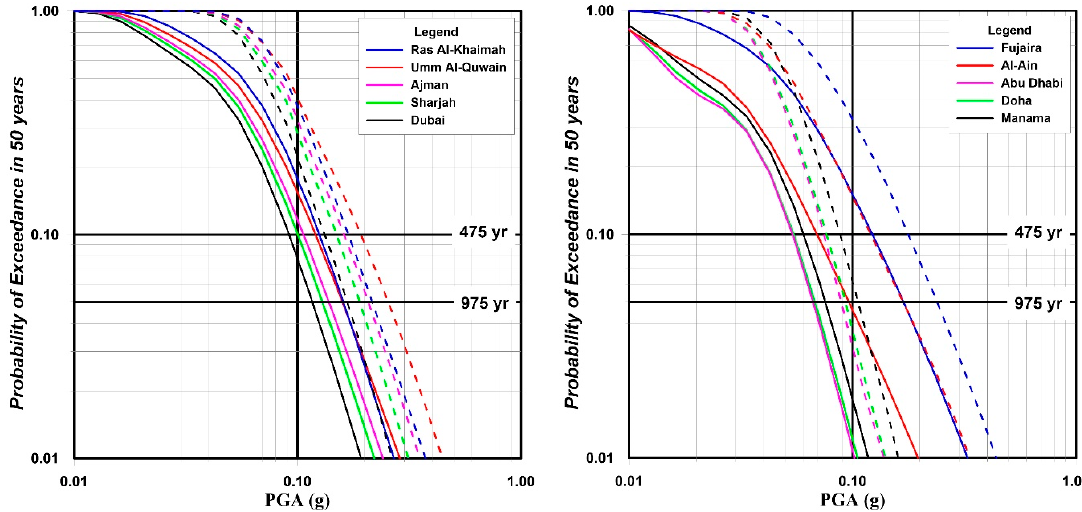
Figure 7. Seismic hazard curves for the studied emirates and cities [Continuous lines: mean values. Discontinuous lines: 90th percentiles].